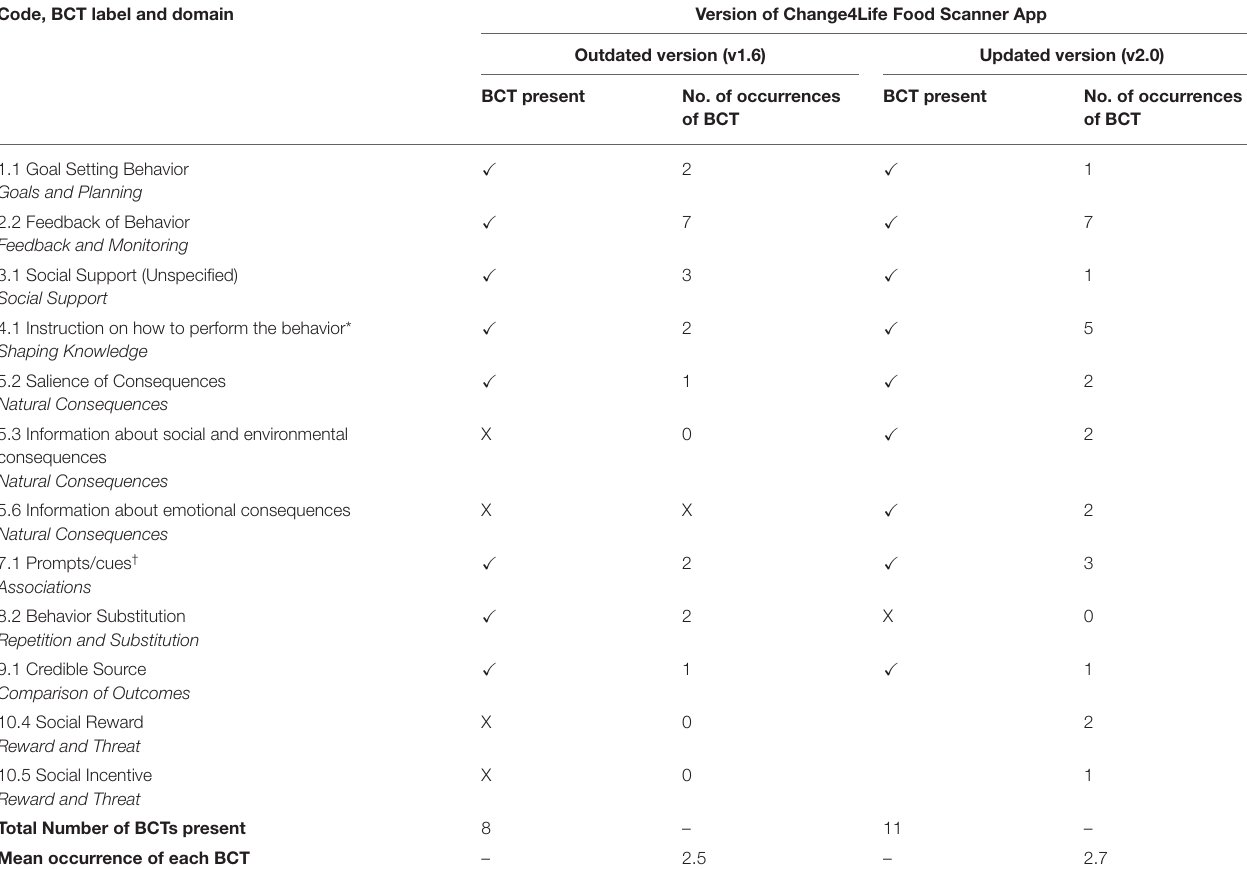
TABLE 1 | A comparison of Behavior Change Techniques (BCTs) in the outdated (v1.6) and updated (v2.0) versions of the Food Scanner app. Code, BCT label and